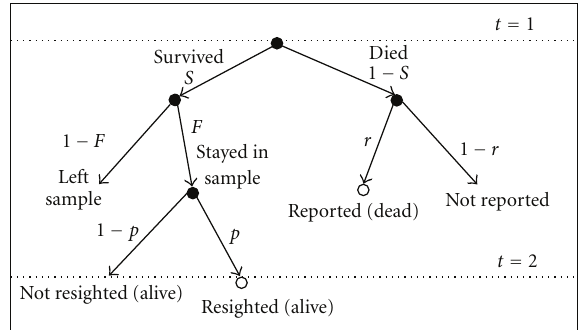
Figure 2: Fate diagram for the live-dead model. The convention used for the parameterization is the one developed by Seber [23], with S representing the probability of survival from one occasion to the next, p the probability of recapture in the following interval given the animal survived the interval, r the probability of being recovered dead, and F the site fidelity. The succession of events occurring during the period of observation is coded in an event history with information on alive or dead in the odd and even numbered places of the event history, respectively. For example, an individual marked and released on the first occasion, which sur- vives the interval between occasion 1 and occasion 2 because it was recaptured at occasion 2, is subsequently recovered dead during the second interval. Its event history for these two intervals is 1011 (seen alive, not reported dead, seen alive, reported